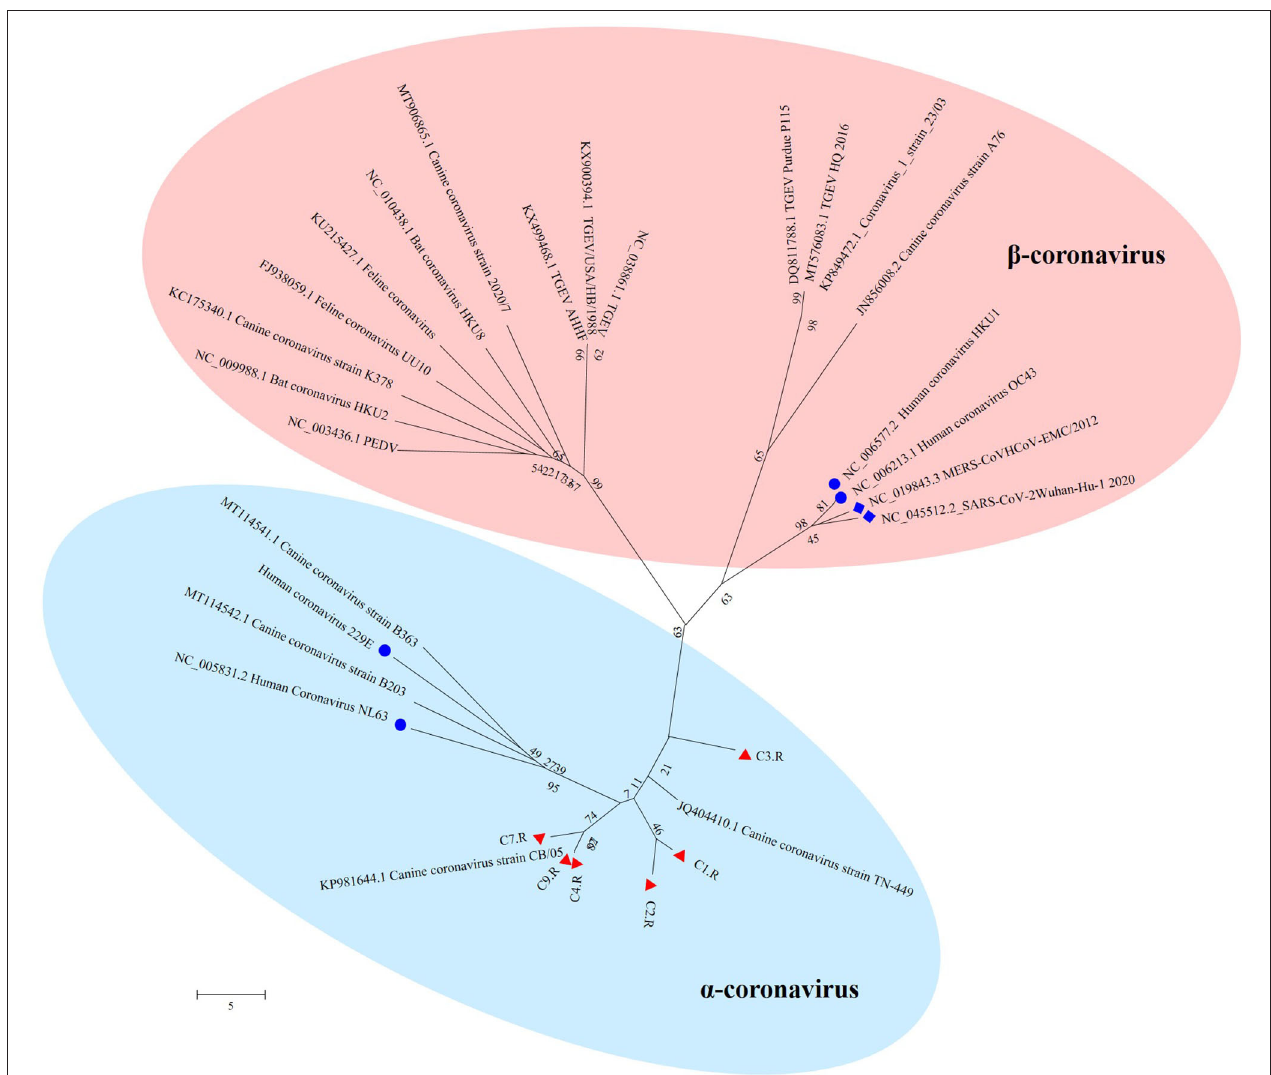
FIGURE 6 | The phylogenetic tree of Coronavirus. The phylogenetic tree was generated by using the MEGA6 software version 6.06 with neighbor-joining method and bootstrapped with 1000 replicates. The assembled sequences in the study are labeled in red triangle. The labeled blue circle represents the Coronavirus from human, and the labeled blue diamond represents the Coronavirus from human resulting in